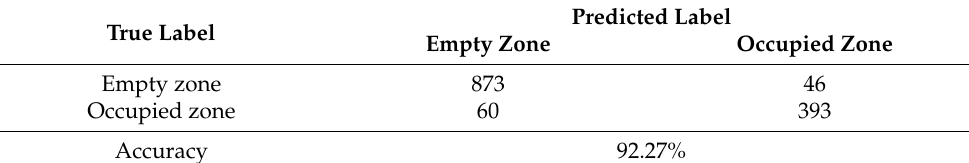
Table 4. Confusion matrix for the neural linear prediction